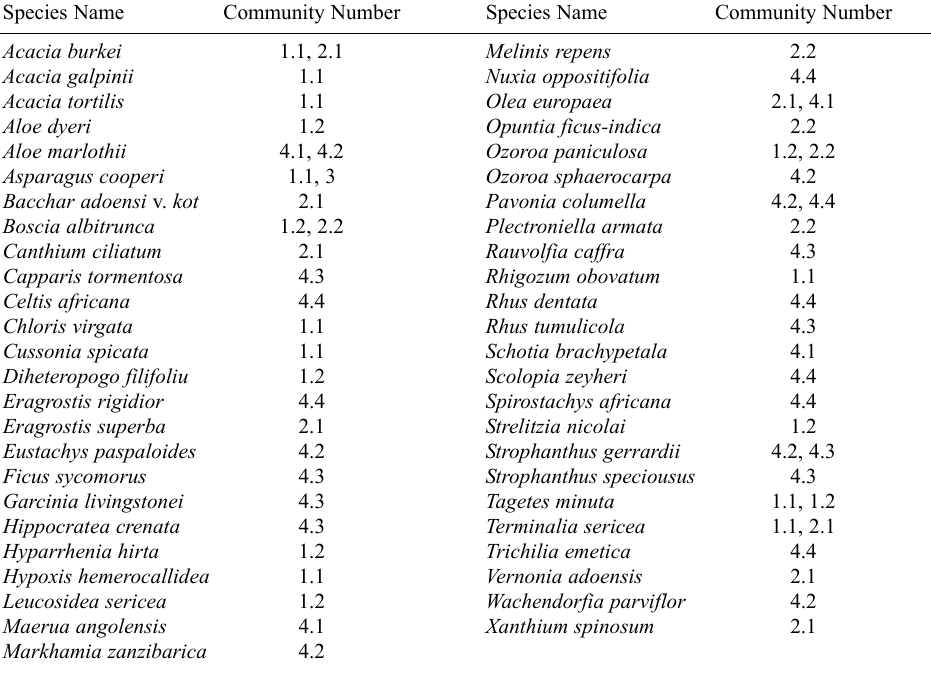
Table of less prevalent plant species occurring at Blydeberg and not represented in table